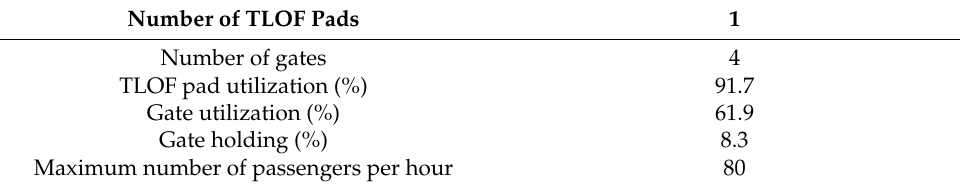
Table 6. Analysis results of vertiport consisting of one TLOF and four